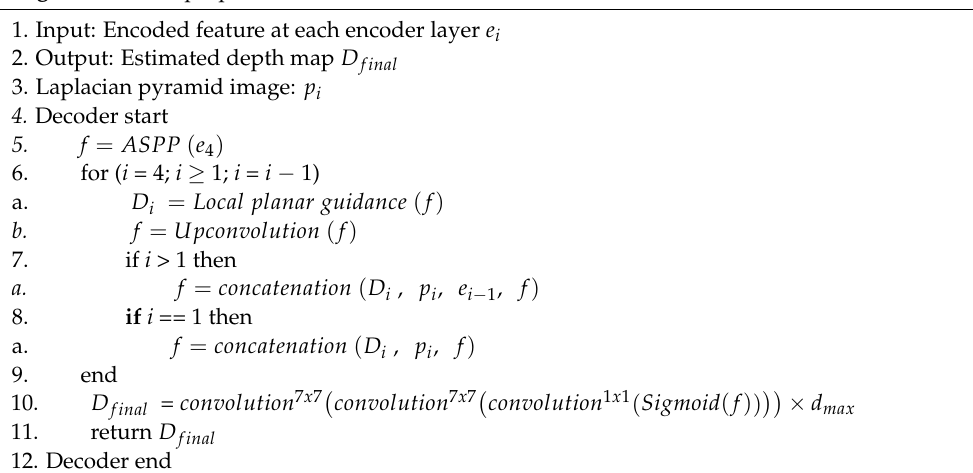
Algorithm 1 The proposed decoder